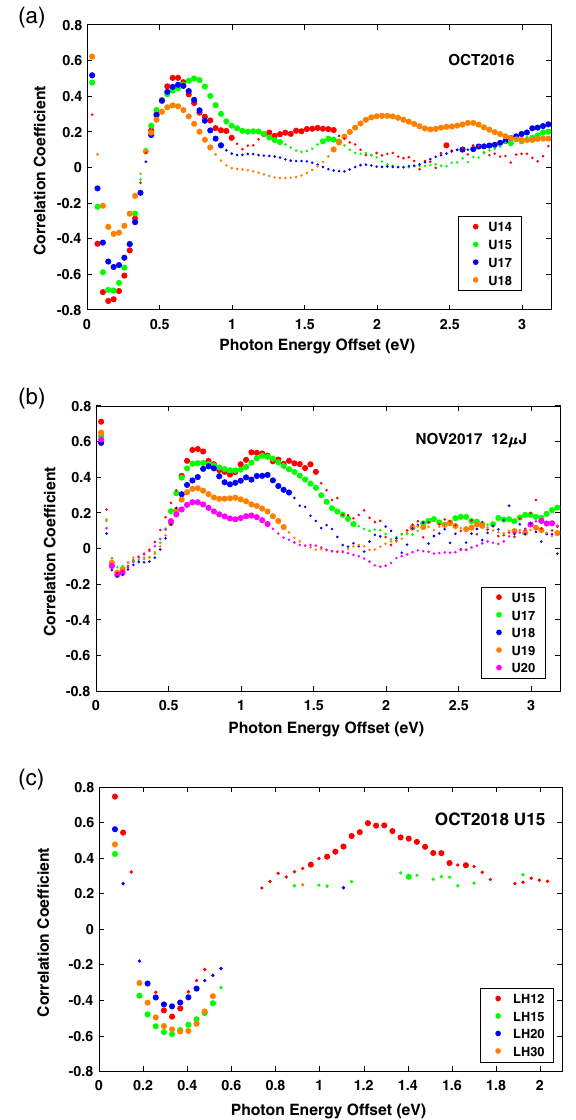
FIG. 14. Pearson correlation coefficients computed for the symmetric pair ½ ω 0 − Δ ω ; ω 0 þ Δ ω (cid:3) . as a function of relative photon energy ℏ Δ ω for (a) and (b) different effective undulator lengths for the 1-keV October 2016 and November 2017 shifts, respectively, and also (c) the 750-eV October 2018 shift at U15 for various LH energies. The larger dots correspond to data whose statistical significance P-value is ≤ 10 − 3 or, equivalently, ≥ 3 . 3 σ